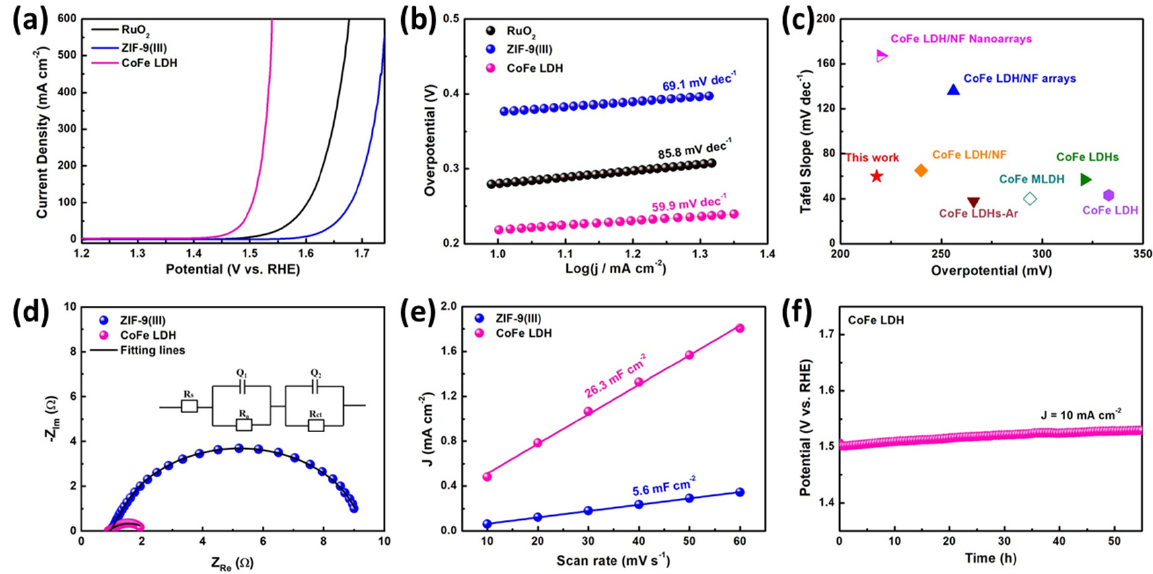
Figure 5. ( a ) LSV curves of ZIF-9(III), CoFe LDH, and commercial RuO 2 , ( b ) the corresponding Tafel plots, ( c ) overpotentials at 10 mA cm − 2 and Tafel slopes of some previously reported CoFe LDH catalysts, ( d ) EIS curves and fitting results for CoFe LDH at 1.52V vs. RHE and ZIF-9(III) at 1.62V vs. RHE, ( e ) electrochemical double-layer capacitance ( C dl ) of ZIF-9(III) and CoFe LDH, ( f ) chronopotentiometry of CoFe LDH.